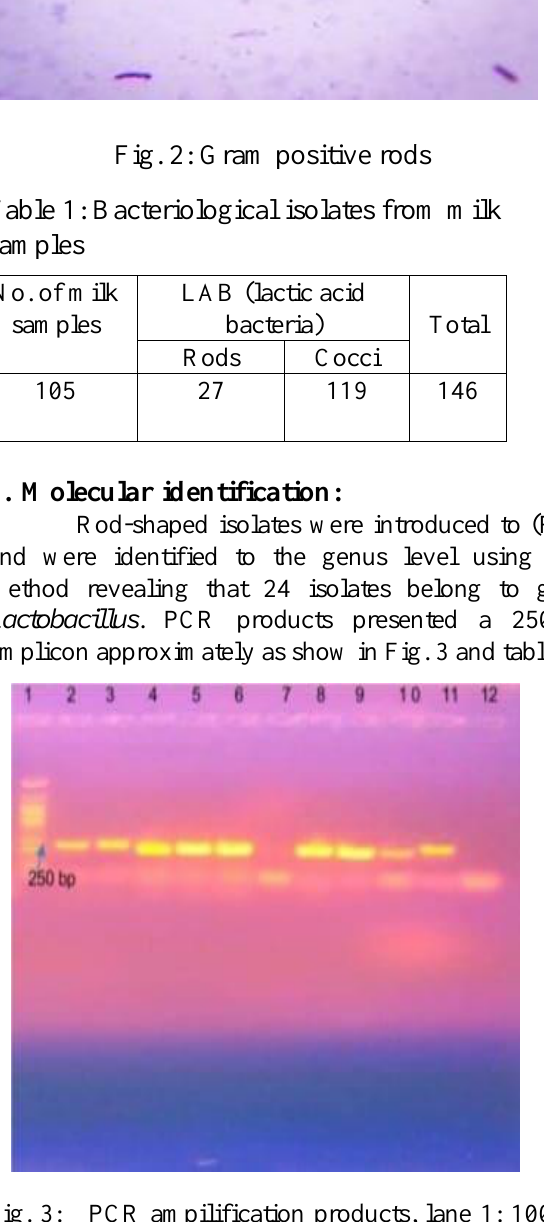
PCR ampilification products, lane 1: 100 bp ladder, lanes from (3-6) and from (8-11) lactobacilli, lane 2: positive control ( Lactobacillus acidophilus La-5), lane 12: negative control, lane 7: negative result.